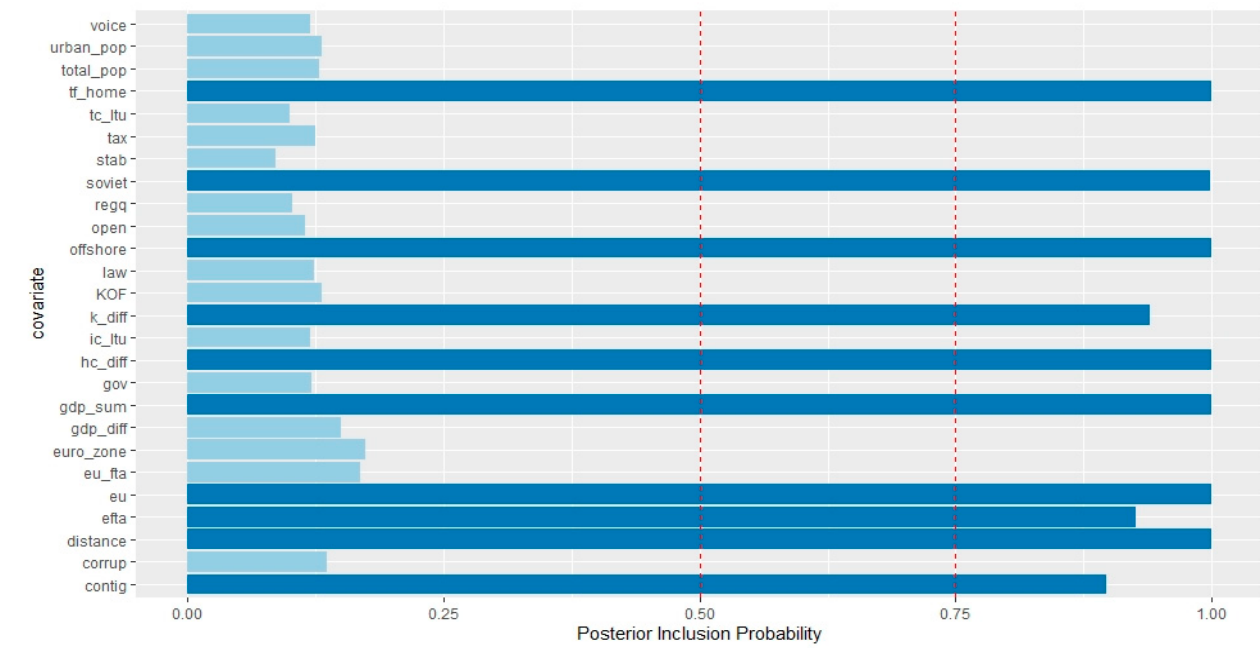
Figure 5. Inclusion probabilities for each of the potential covariates for Lithuania, general case (2004–2017).